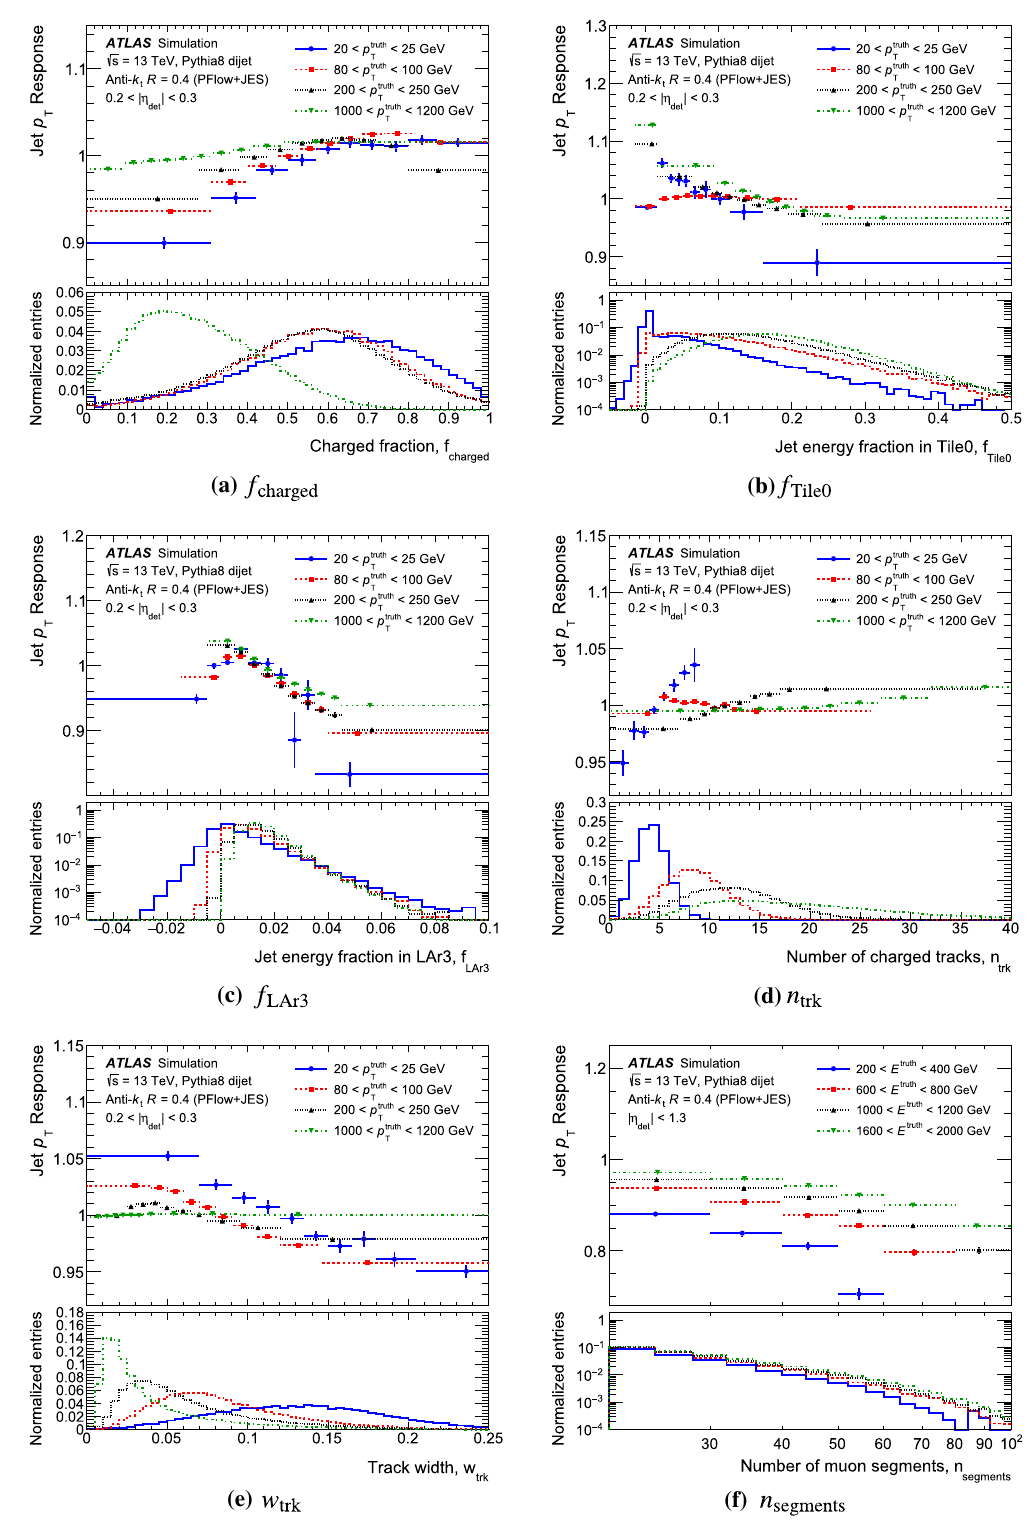
Fig. 7 Jet response for PFlow jets in four broad p true ated with the jet. Jets at the PFlow+JES scale with 0 . 2 < | η det | < 0 . 3 ranges as a func- T tion of each of the six observables used in the GSC a the fraction of the (except for n segments which is shown for | η det | < 1 . 3 due to low statis- jet p T carried by charged particles, b the fraction of energy in the first tics) are selected from a sample of Pythia 8 dijet MC events and the correspondingprecedingGSCstepshavebeenappliedaccordingly.The layer of the Tile calorimeter, c the fraction of energy in the third layer error bars show only the statistical uncertainty. The bottom panels show of the electromagnetic calorimeter, d the number of tracks, e the track the normalized distributions of the width, and f the number of muon spectrometer track segments associ-